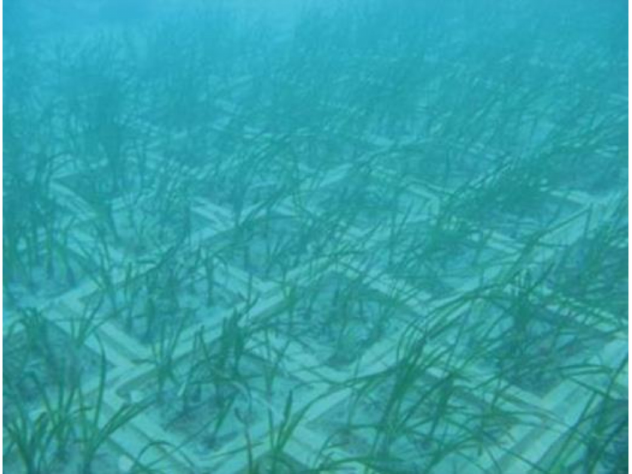
Figure 13. A nightmarish Posidonia oceanica transplanting operation, in the framework of a so-called compensatory measure. Punta San Pietro, Ischia Island, Naples, Italy). From Carannante